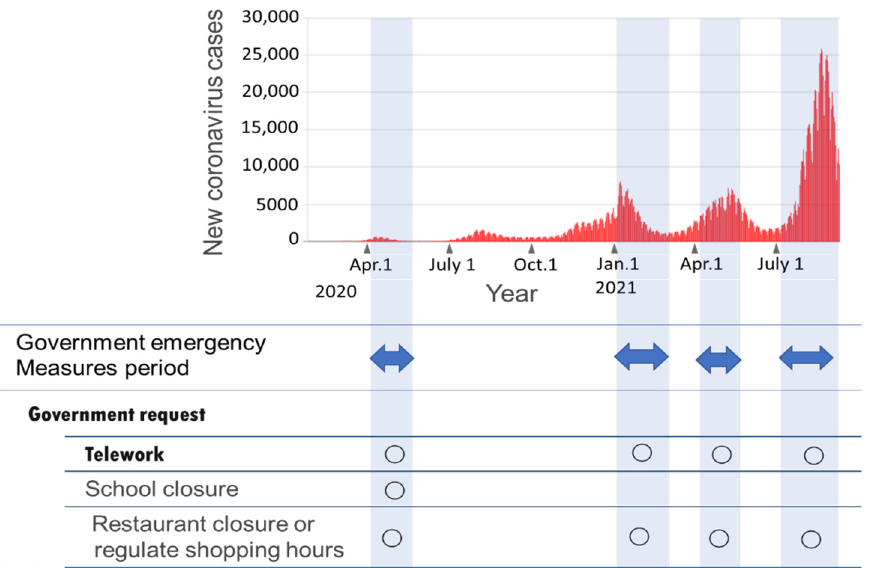
Figure 1. Government emergency measures against the COVID-19 (coronavirus) pandemic in Japan [4].